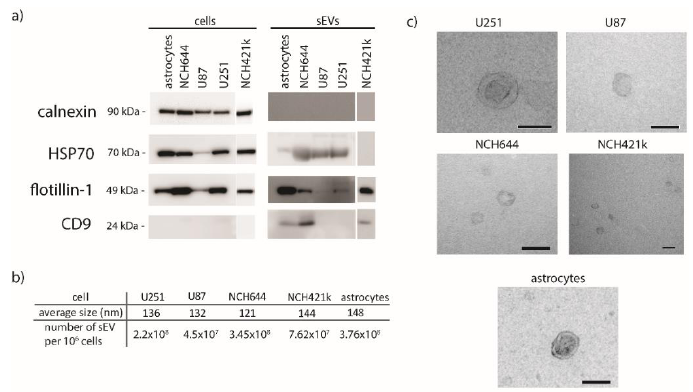
Figure 4. Molecular characterization of sEVs isolated from normal astrocytes and GBM cell lines. ( a ) Western blot of cell and sEV lysates. Antibodies directed against proteins enriched in sEVs (HSP70, flotillin-1, CD9) and against a marker for endoplasmic reticulum (calnexin) were used. ( b ) Mean size of sEVs was determined by nanoparticle-tracking analysis. ( c ) Transmission electron microscopy images of sEVs. Scale bare is 100 nm. sEVs—small extracellular vesicles.